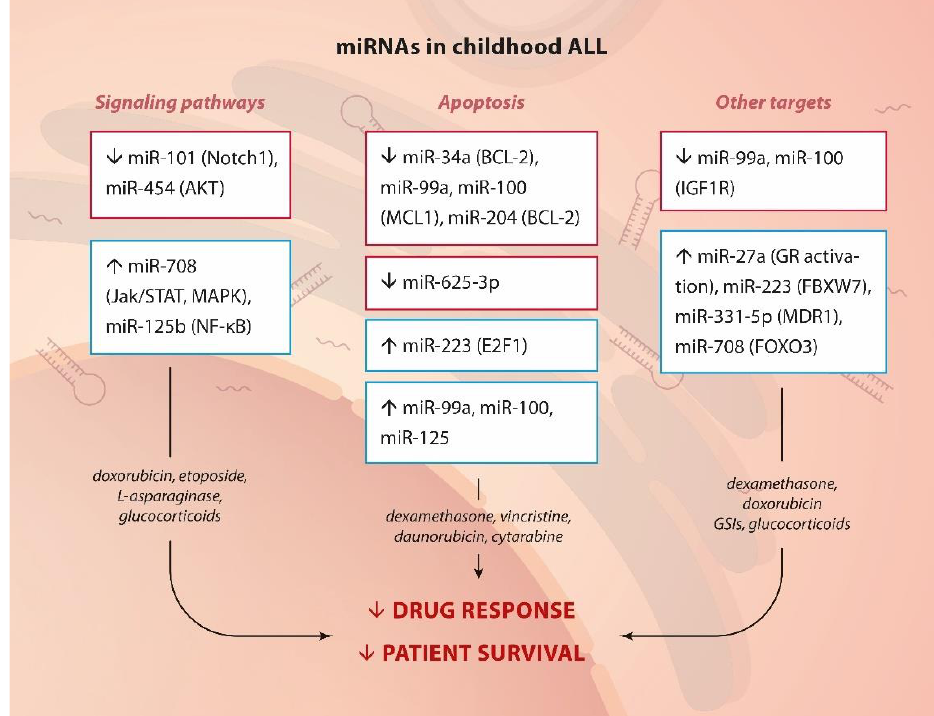
Figure 2. miRNA and drug resistance in childhood ALL.Summary of up- or down-regulated miRNAs, their targets or pathways they affect (in brackets) and their involvement in drug resistance in childhood ALL.